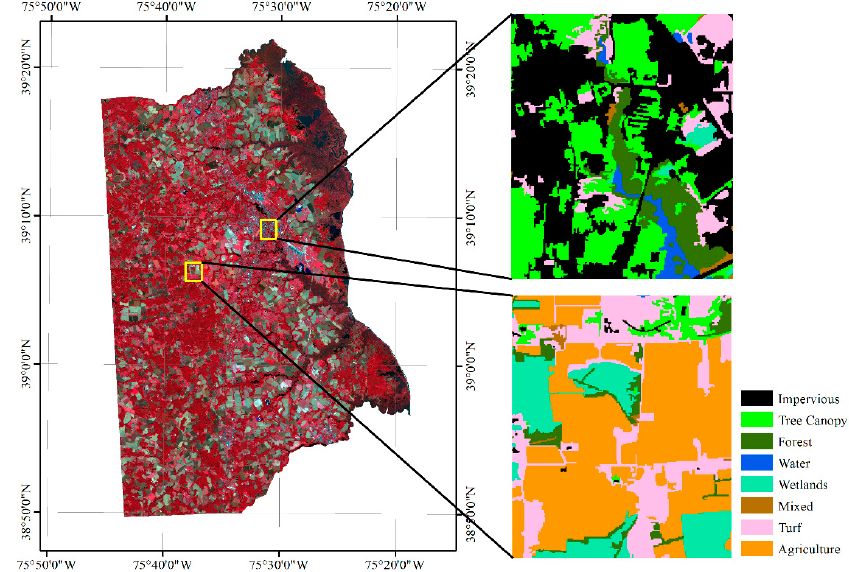
Figure 11. Location of the sample region for building the graph of Kent County.